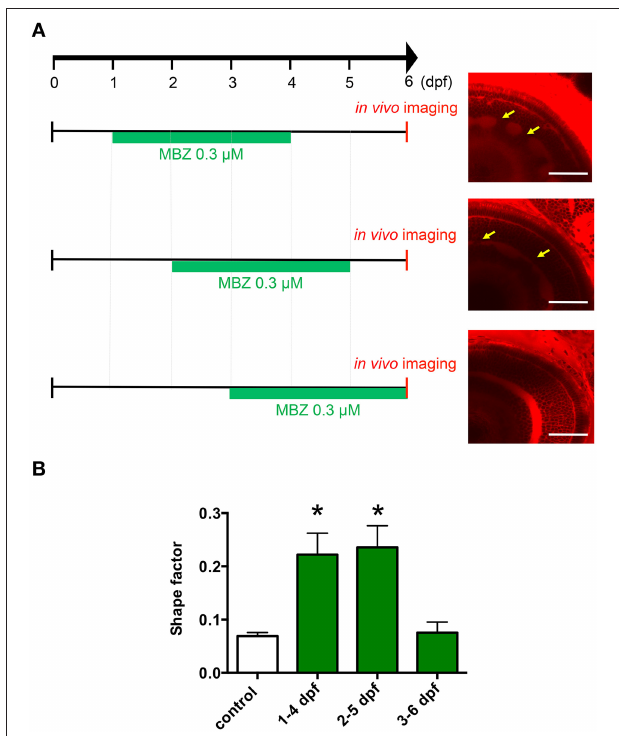
FIGURE 2 | Development during 2 and 3dpf was the critical window for developmental toxicity of MBZ in the zebrafish retina. (A) Zebrafish were treated with 0.3 µ M MBZ during the indicated periods. At 6dpf, zebrafish were stained with ZMA462 and the retinas were imaged in vivo . The malformations in the IPL caused by MBZ are indicated by yellow arrows. Scale bar: 50 µ m. (B) Quantitative analysis of the developmental toxicity of 0.3 µ M MBZ in the zebrafish retina. The shape of the IPL in each zebrafish was quantified using the shape factor. n = 5 for control, n = 6 for 1–4dpf, n = 4 for 2–5dpf and 3–6dpf, * p < 0.05 compared with